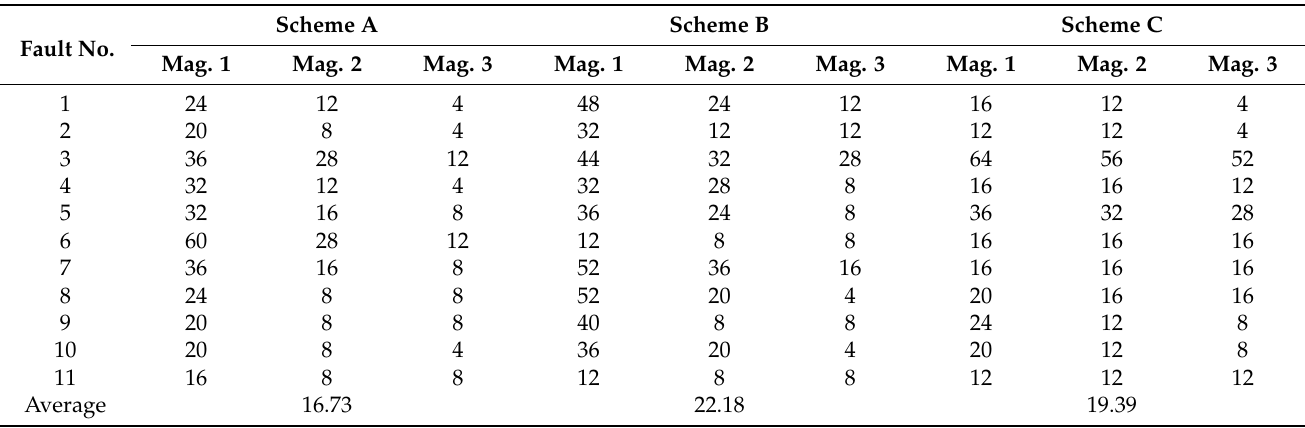
Table 10. Fault diagnosis time (s) in abrupt